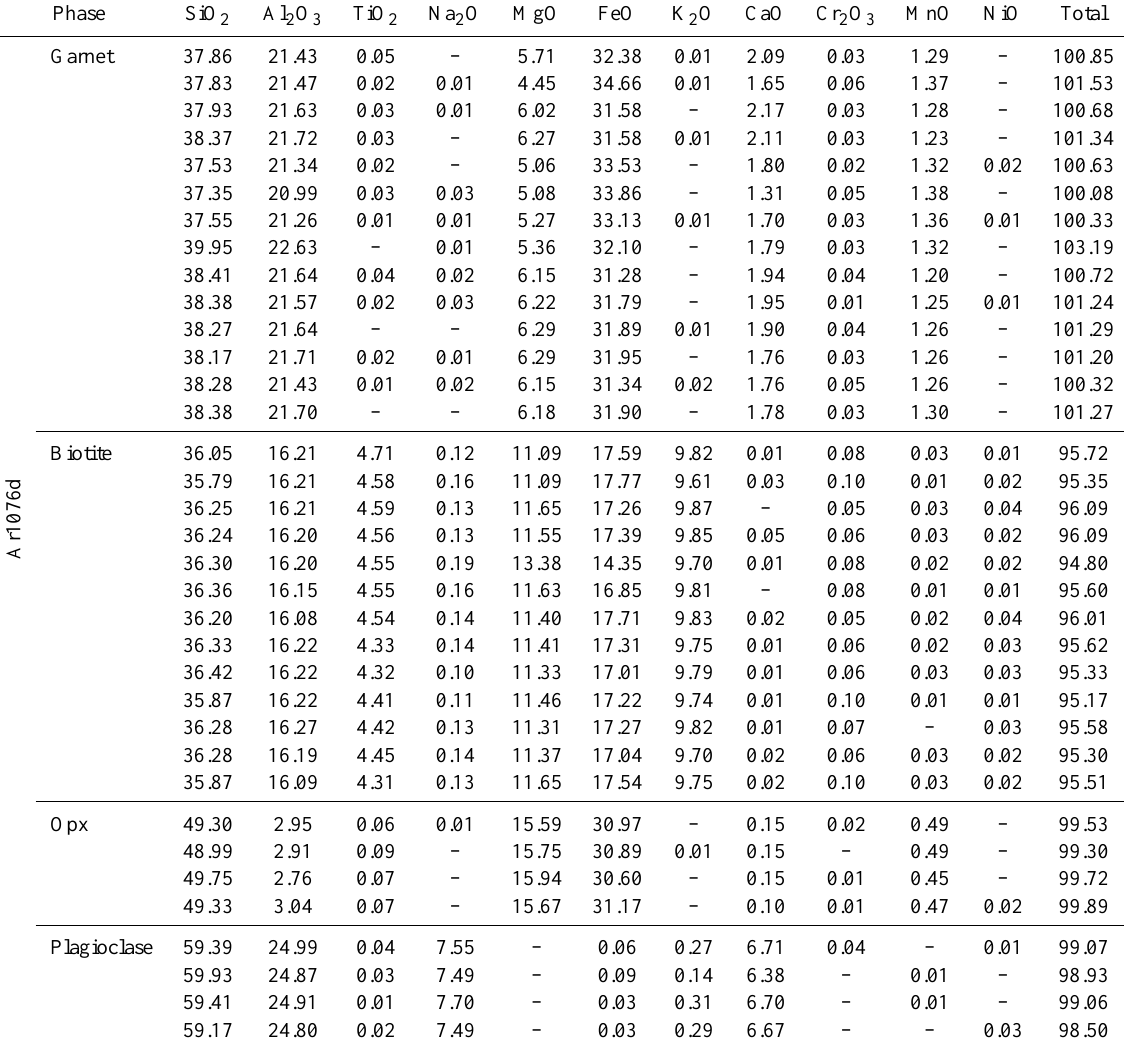
(Table 4). The proportion of liquid in the system, inferred